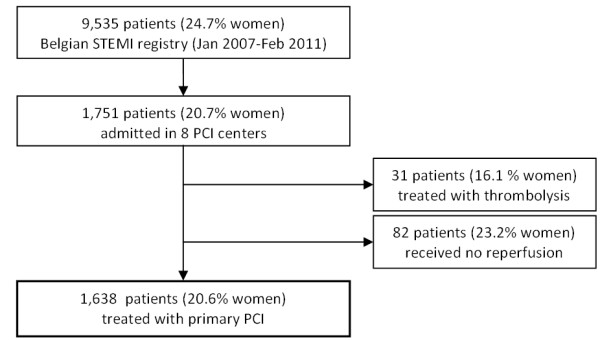
Study population, undergoing primary PCI in 8 (out of 25) selected centers.